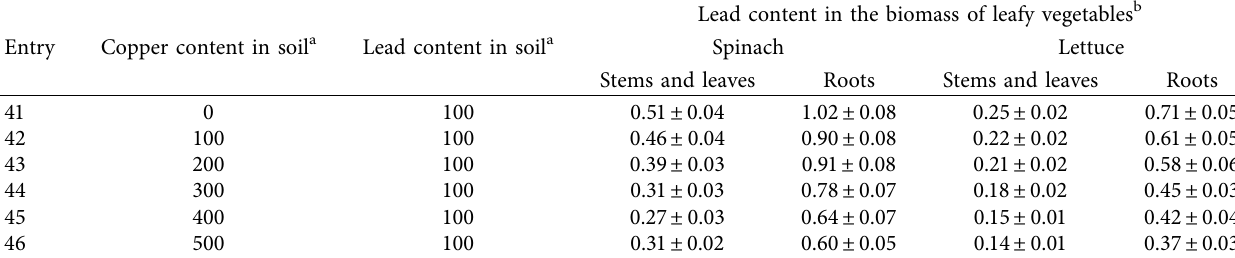
Table 7: Effect of copper on the accumulation of lead from soil of leafy vegetables.